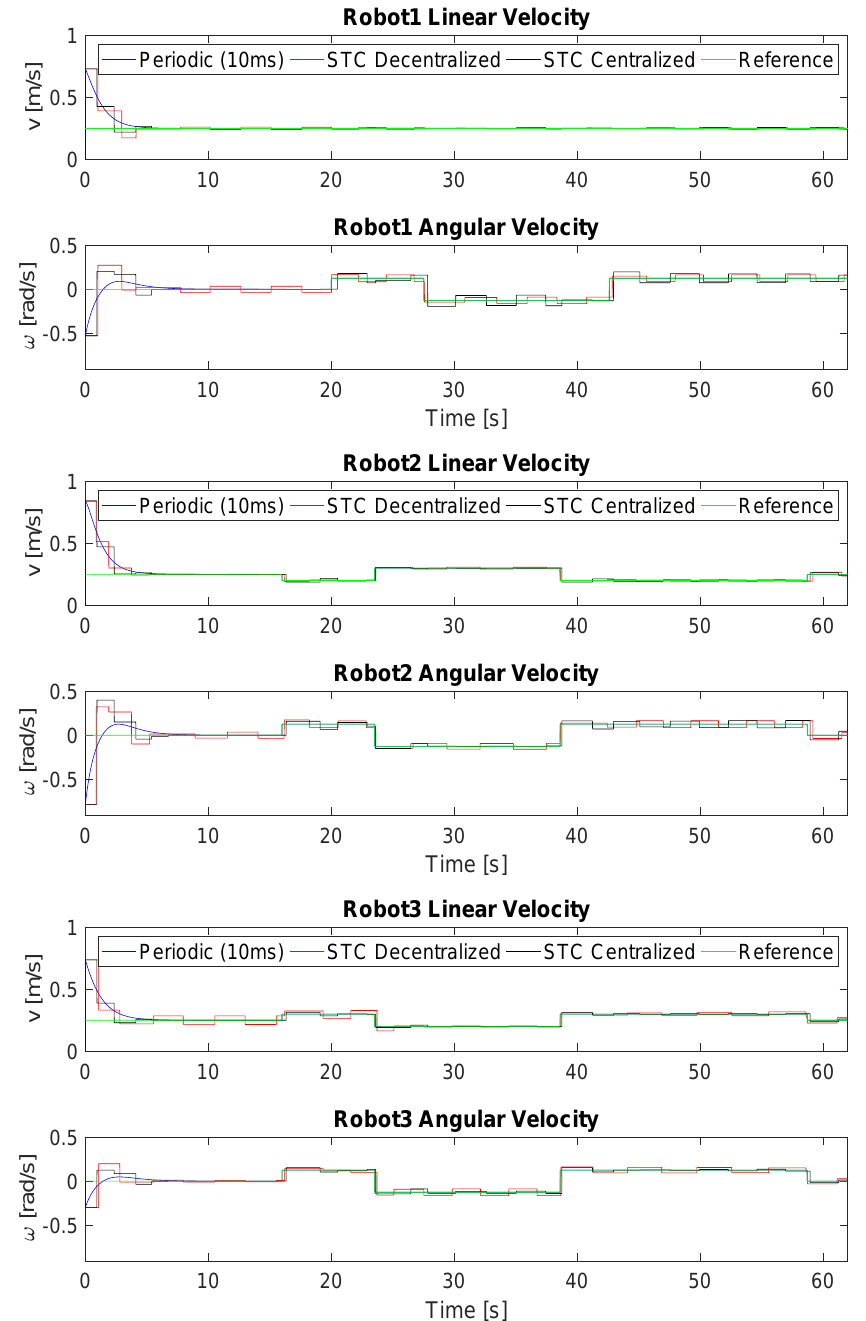
Figure 5. Linear and angular velocity references and commands of the formation. Robot 1 is represented in top figure, Robot 2 in middle one and Robot 3 in the bottom. The velocity done by each robot is presented in blue for the periodic implementation, in red for the STC with decentralized triggering (27) and in black for the centralized triggering (26). The velocity reference of each unit is presented in